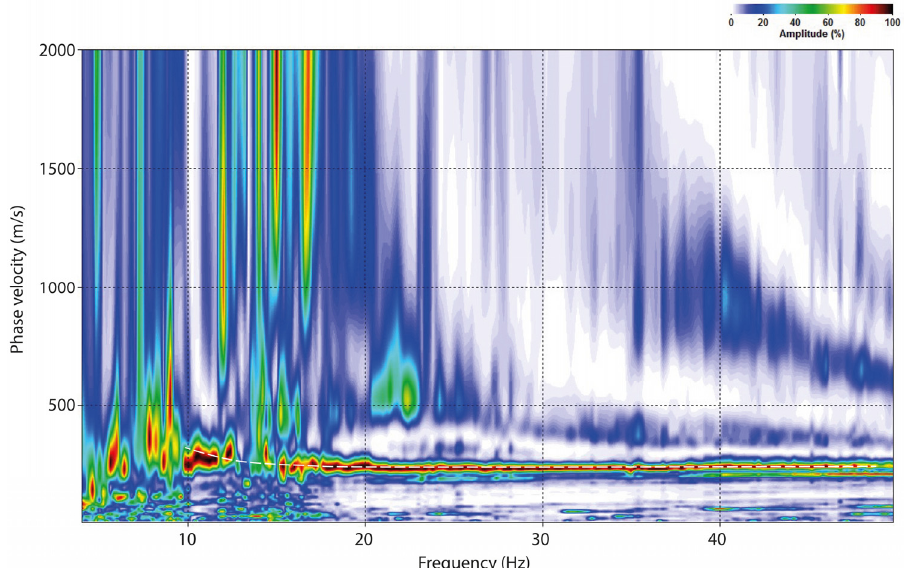
Figure 5. Example of a dispersion curve (white dashed curve) obtained for a shot-gather in Almeria city with MASW.